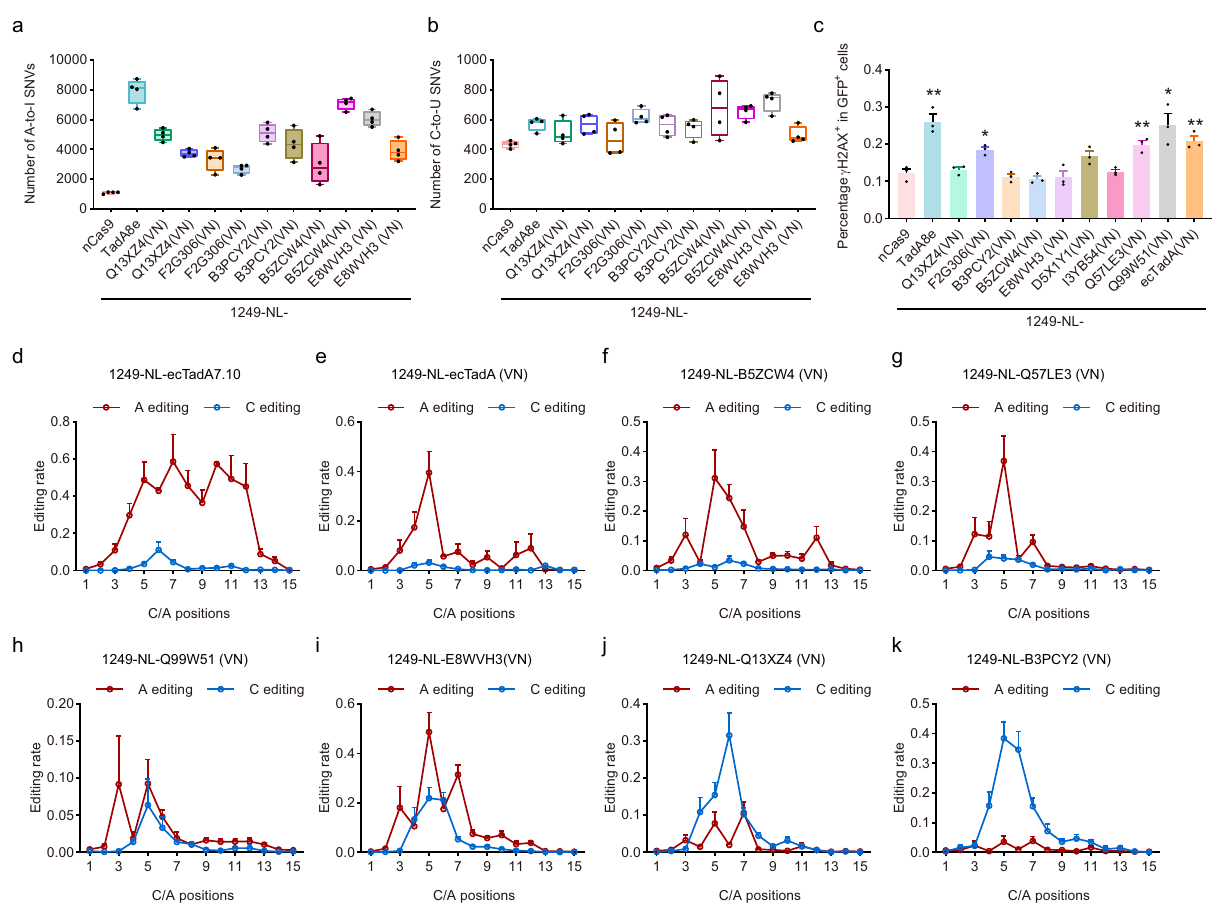
Fig. 3 | Off-target effects, genotoxicity, and editing scopes of representative TadAortholog-derivedbaseeditors.a , b BoxplotsshowingthenumberofRNAA- to-I ( a ) and C-to-U edits ( b ) induced by representative base editors or nCas9 con- trol. n =4 biologically independent experiments. Box plots here are de fi ned by whiskersintermsofminimaandmaxima,andthecenterandboundsoftheboxby quartiles(Q1 – Q3). c Quanti fi cationof γ H2AXsignalinginHEK293Tcellstransfected with representative base editors. The percentage of γ H2AX positive population withinGFPpositivecellsisshown.Datashownhererepresentmeansofresultsfrom biologicallyindependent experiments. Data werepresentedasmeanvalues±SEM. Exact P values were as follows, P =0.0037/TadA-8e, 0.01/F2G308(VN), 0.0084/